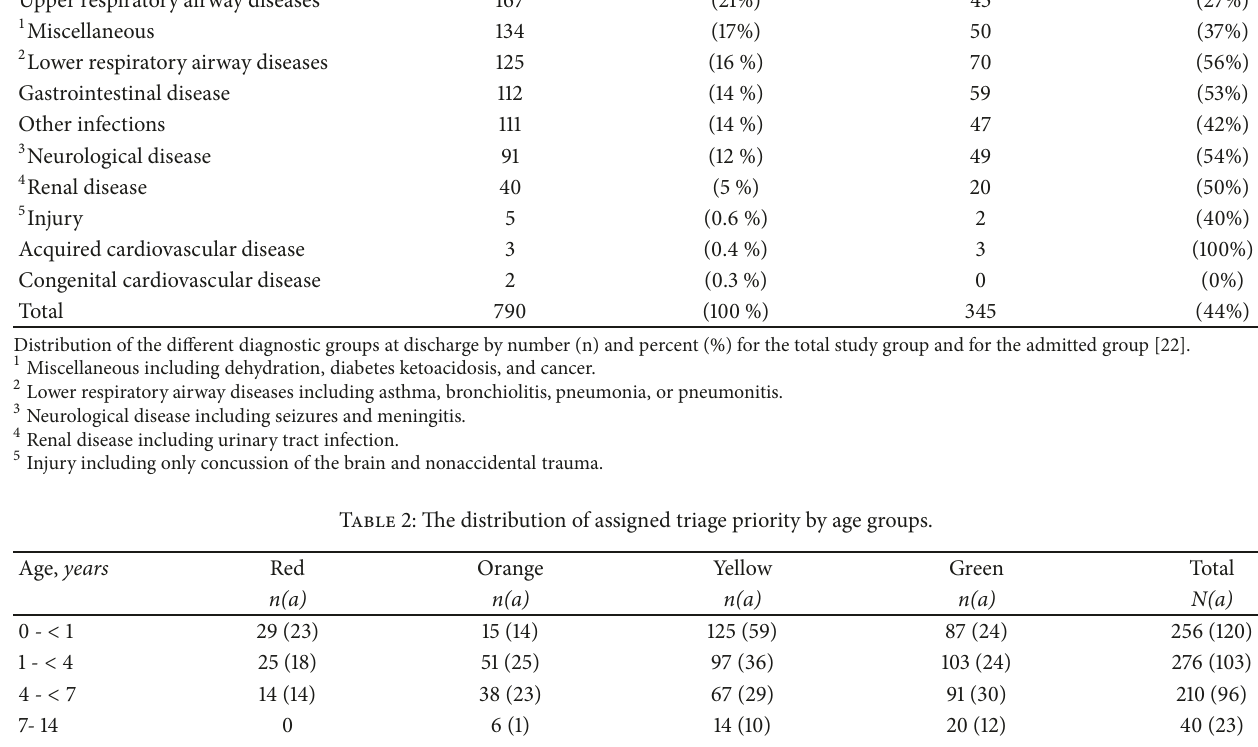
sensitivity was increasing and the undertriage was decreasing for the children less than 4 years of